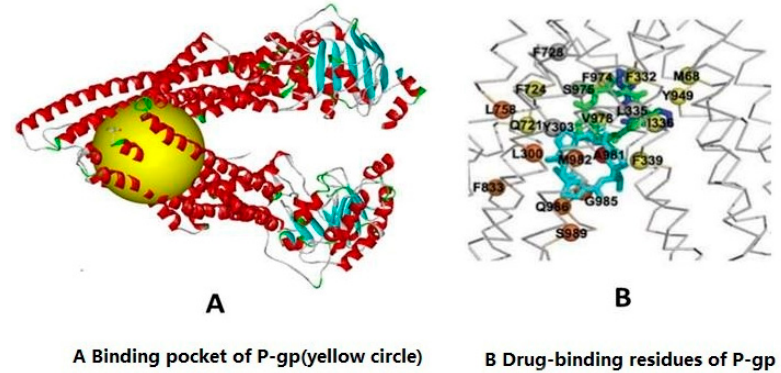
Figure 2. Binding pocket and drug-binding residues of P-gp. ( A ) Binding pocket of P-gp (yellow circle); ( B ) Drug-binding residues of P-gp. Yellow circle: binding pocket; Red chain: NBD1; Blue chain: NBD2; The number corresponding to the color is the P-gp protein drug binding site of amino acid residues in the intracellular nucleotide-binding domain. Table 1. Detailed binding modes of ligands with P-gp and the LibDock Score.